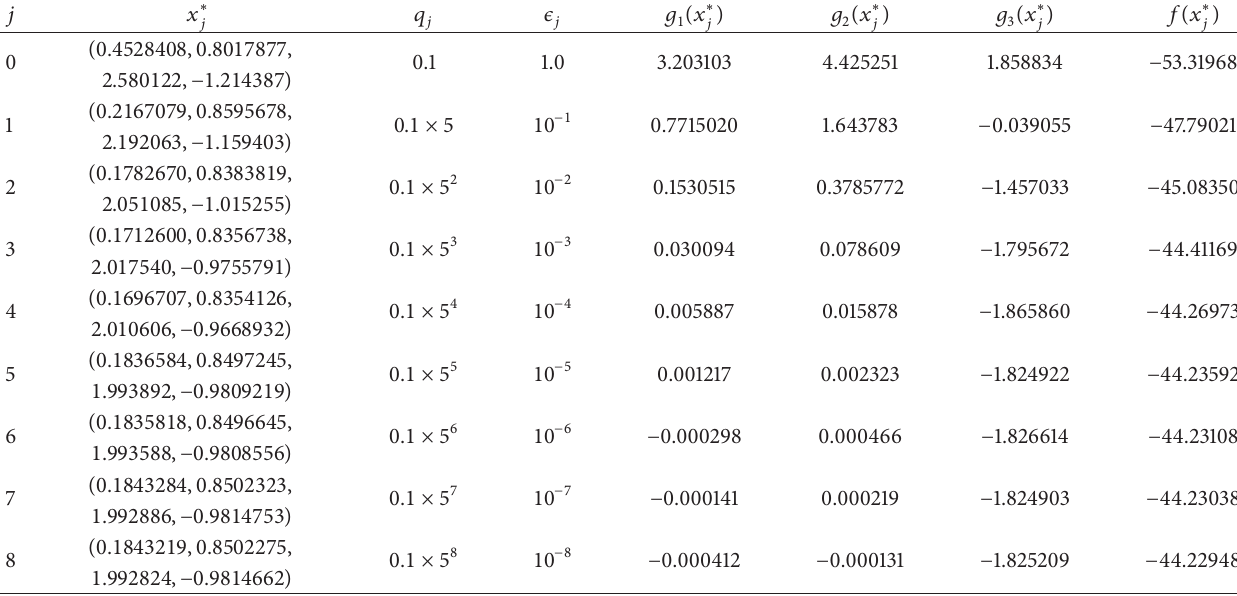
Table 5: Numerical results for Example 2 by Algorithm 10.